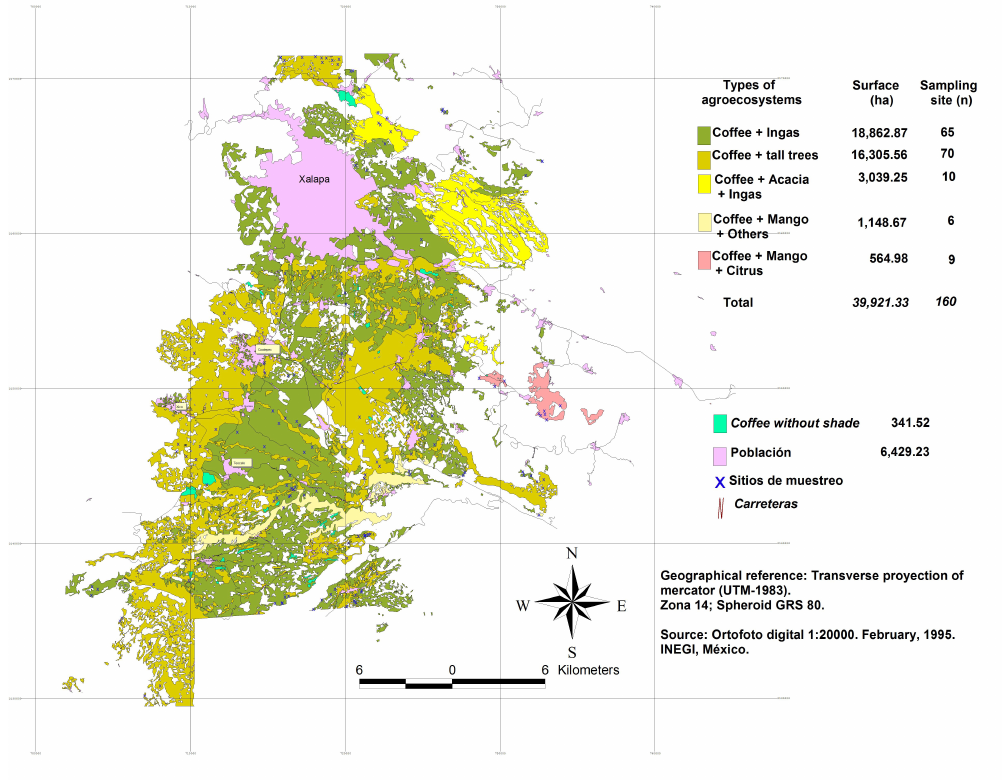
Figure 2. Map showing the spatial distribution of sampling sites by type of coffee agroecosystem in the study region, Veracruz,